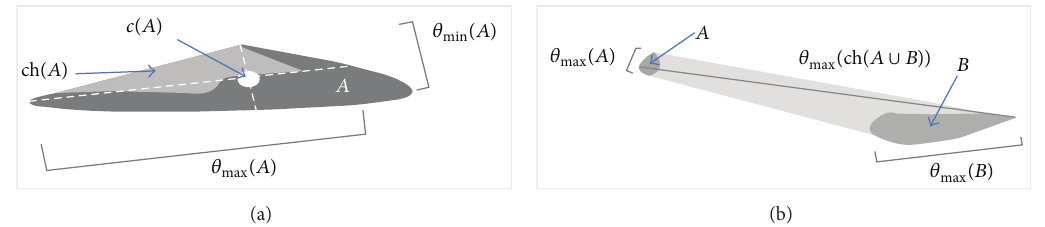
Figure 1: (a) Minimal and maximal diameter of a set A of Cartesian points. (b) Grade of distinctness 𝑑𝑐(𝐴, 𝐵) of A and B .